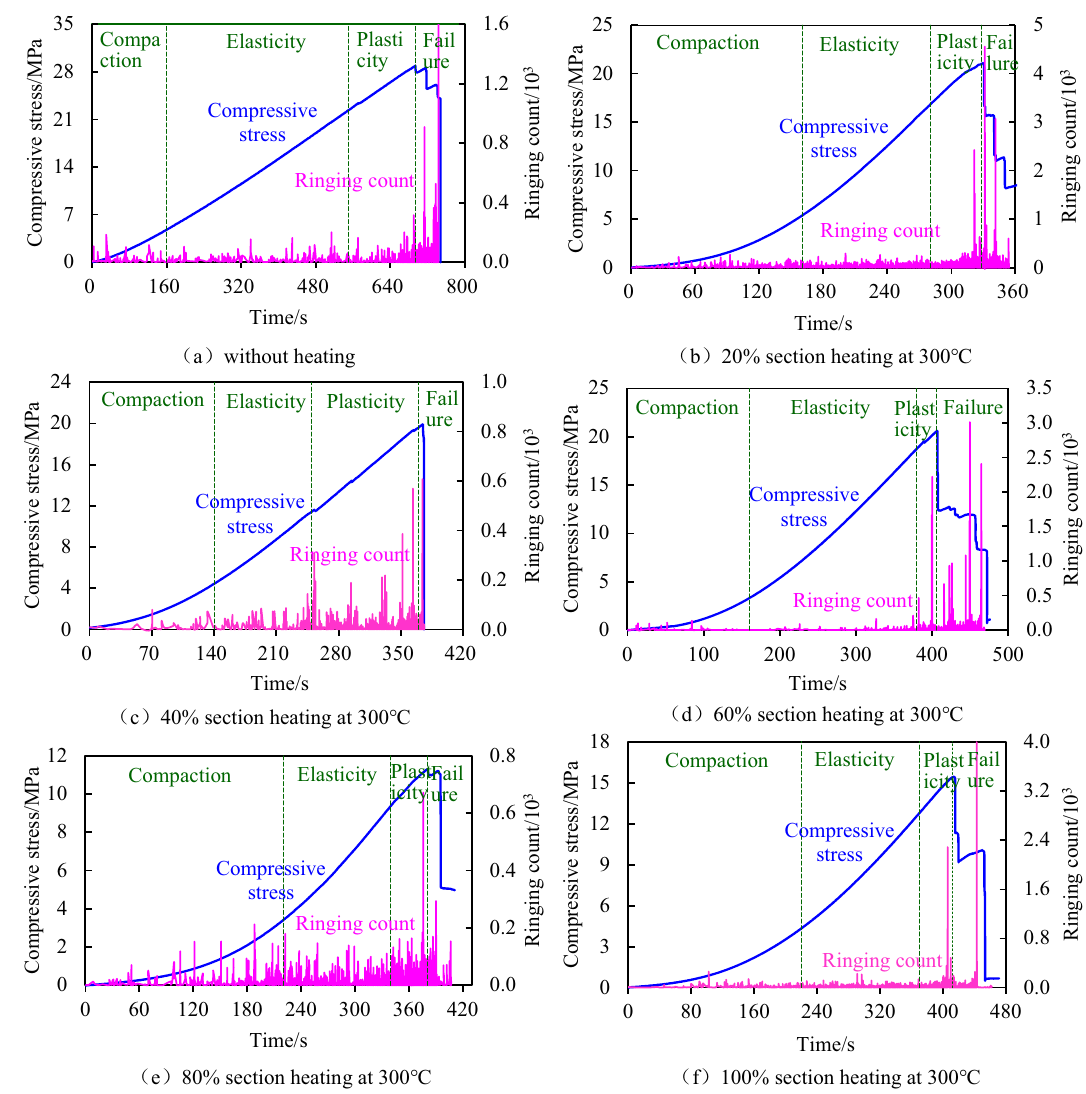
Figure 10. Acoustic emission characteristics of coal samples under the axial load after segmented high- temperature